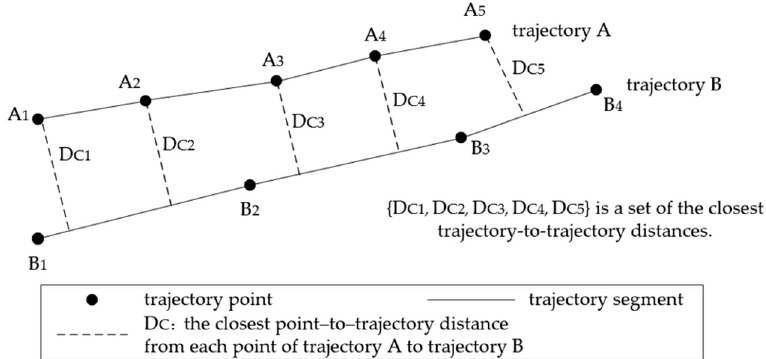
Figure 1. Schematic of the closest trajectory-to-trajectory distance.